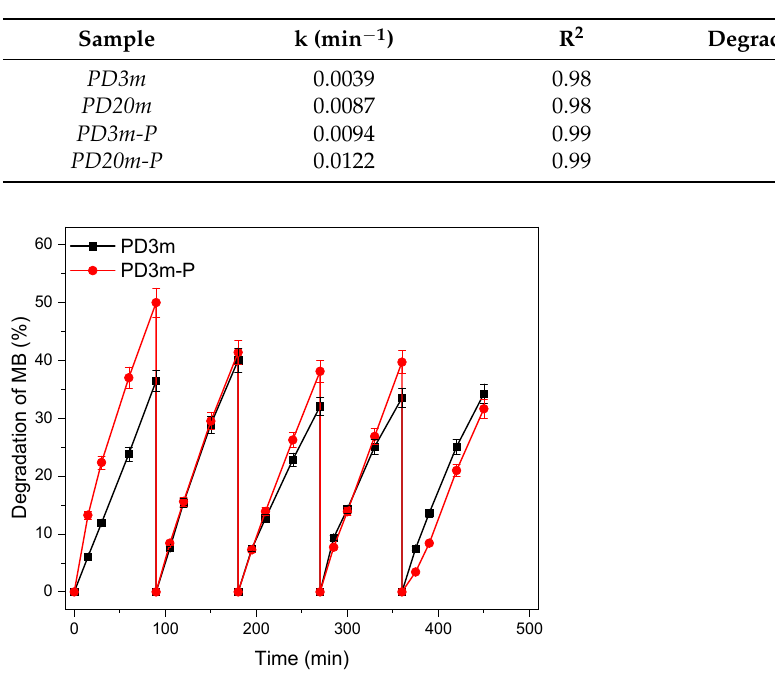
Figure 7. Photocatalytic performance of PD3m and PD3m-P in the MB degradation experiment, measured over five